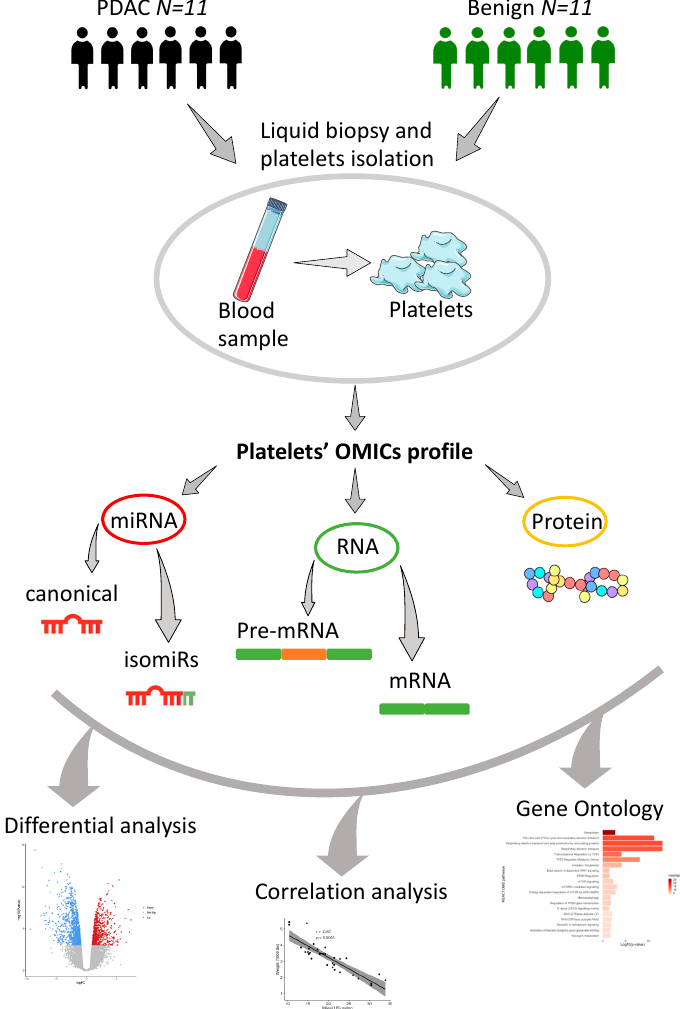
Figure 1. Workflow of platelets omics profiling. Platelets were isolated from 22 age and sex-matched patients with PDAC and benign diseases. Small-RNAs, RNA transcripts (PDAC samples = 11; benign samples = 11) and proteins (PDAC samples = 8; benign samples = 11) were isolated and sequenced following validated protocols [28,37]. Bioinformatics tools were adopted to quantify canonical as well as isomiRs from smallRNA-seq, mRNA and intron-spanning reads from RNA- seq, and proteins. Downstream analyses were carried out using standalone tools for differential analysis of all data types comparing PDAC versus benign platelets; intra group correlation analysis between miRNAs, mRNAs and proteins of matched PDAC and benign platelets and, lastly, gene ontology mining.